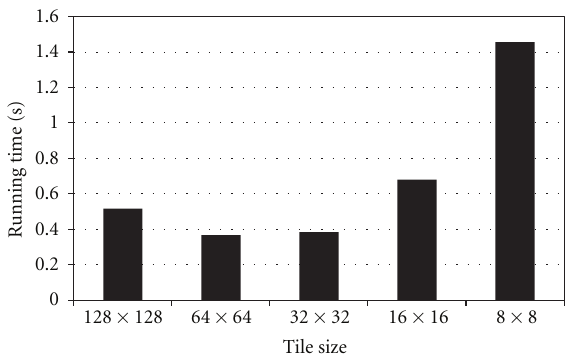
Figure 6: Comparison of di ff erent tile sizes for MM.